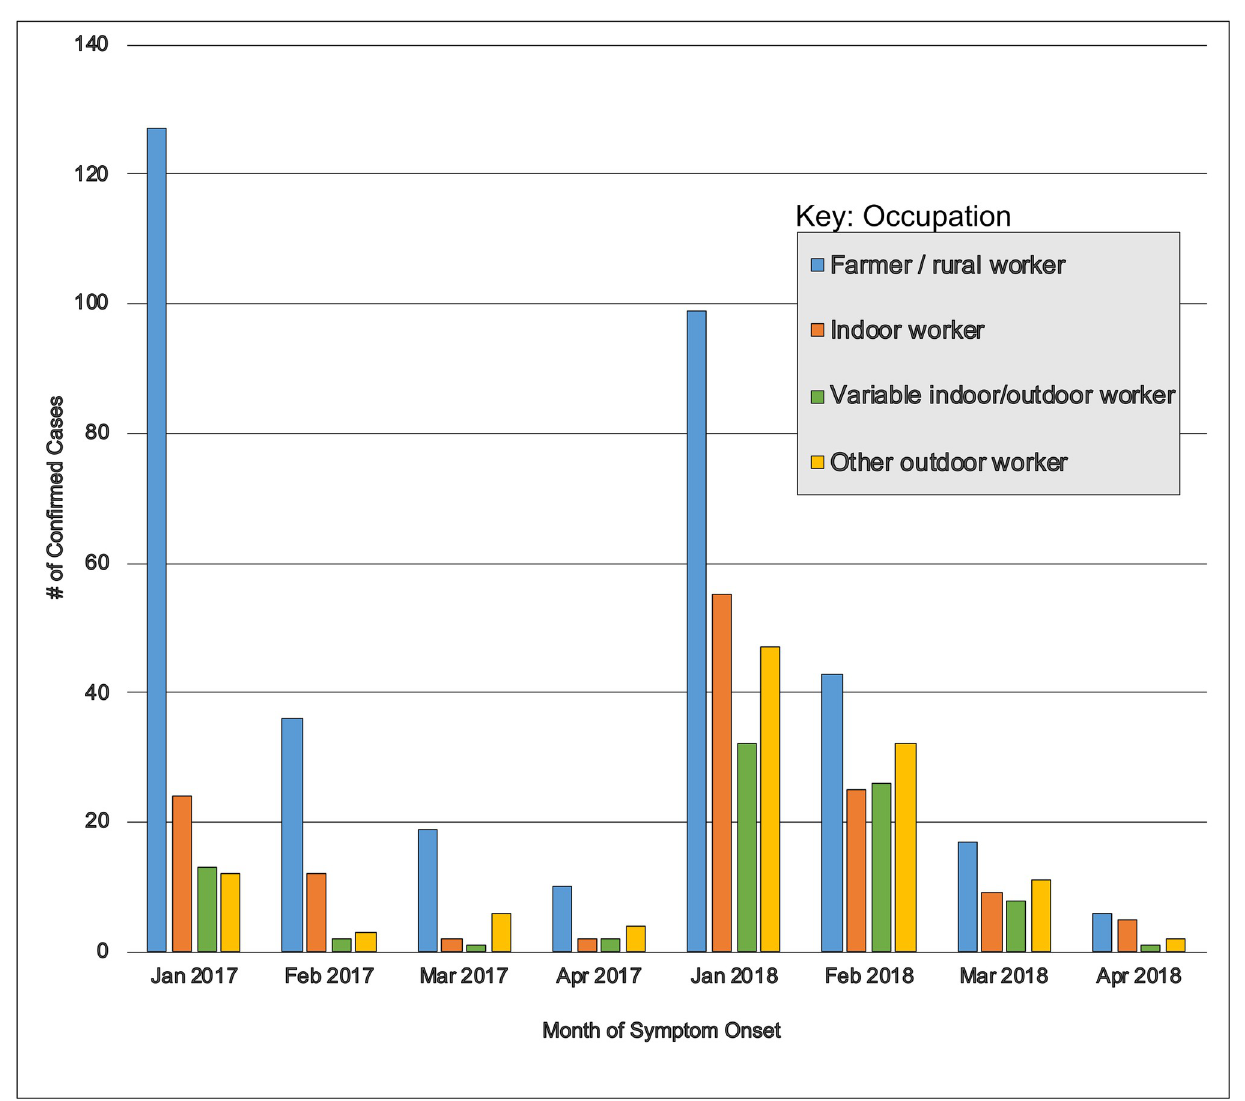
Fig 4. Occupation of yellow fever virus cases over the course of the epidemic. Abbreviations: Jan = January; Feb = February; Mar = March; Apr = April. Farmers and rural workers (blue bars) dominated the cases in the first year of the epidemic (2017). This was also the predominant group at the start of each wave of the epidemic (January 2017 & January